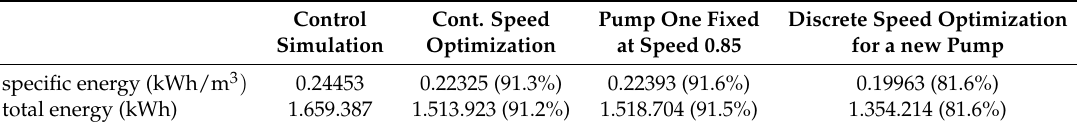
Table 2. Energy savings for optimized speed